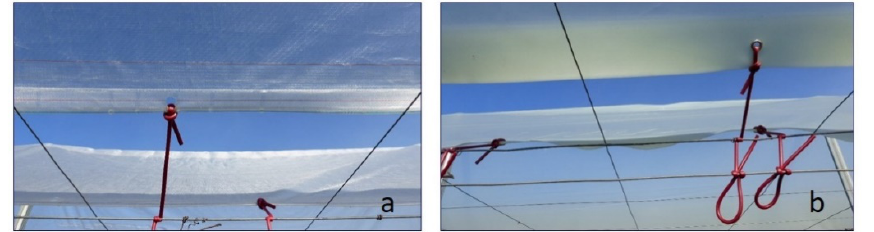
Figure 2. Polyethylene plastic sheets covering the top of vineyard C (Coverlys ® agrotextile, ( a )) and vineyard S (Serrosol film, ( b )).